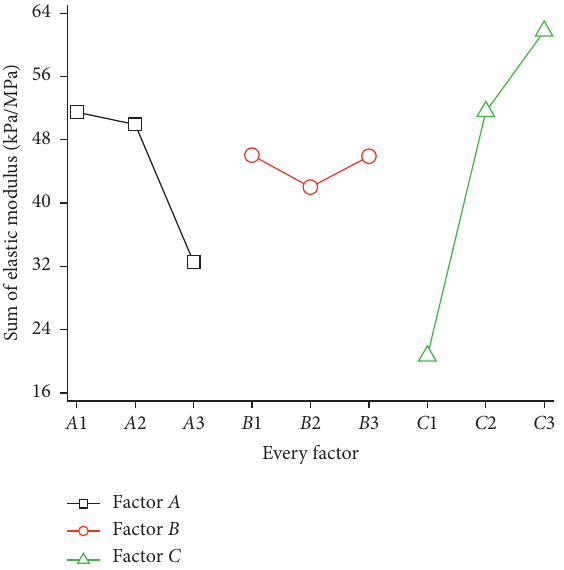
Figure 4: Elastic modulus of trend diagram.